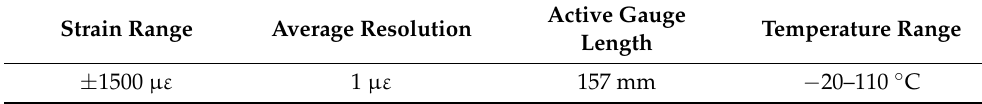
Table 3. Parameters of sensors.